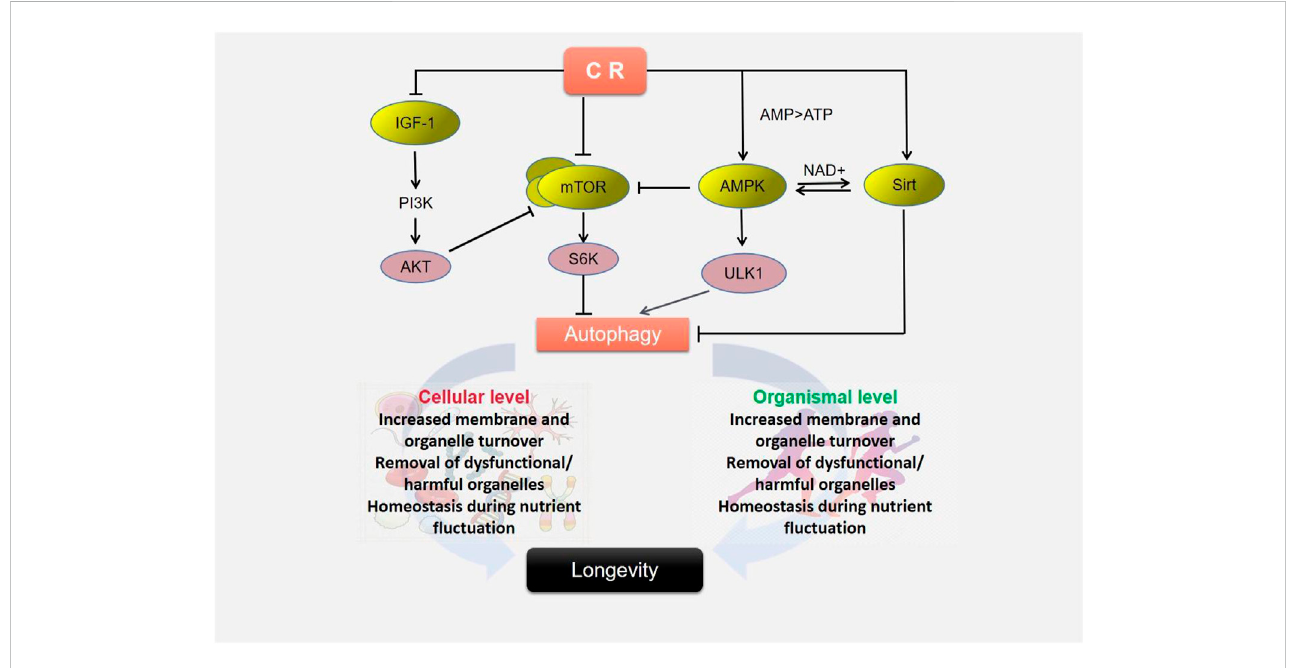
FIGURE 2 Caloric restriction triggers autophagy to extend